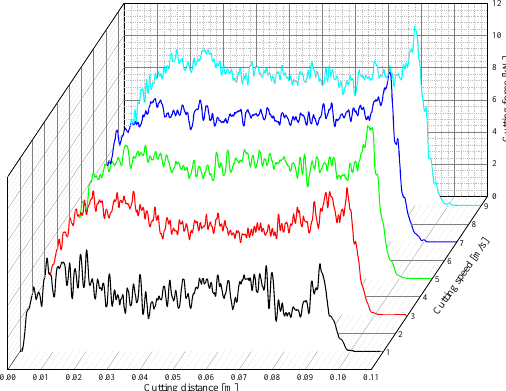
Figure 16. The cutting force curves with different cutting speeds.